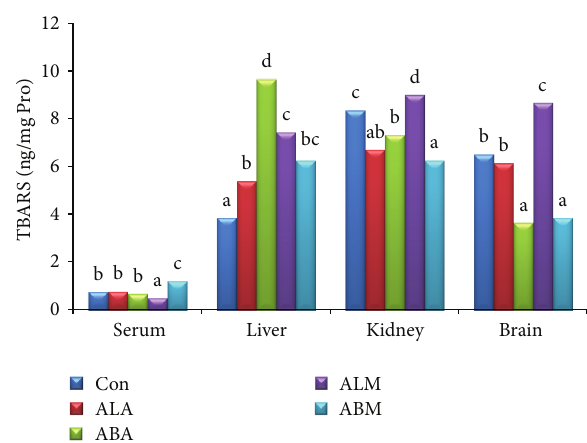
Figure 4: TBARS levels of control and extract treated groups (ng mg −1 Pro).